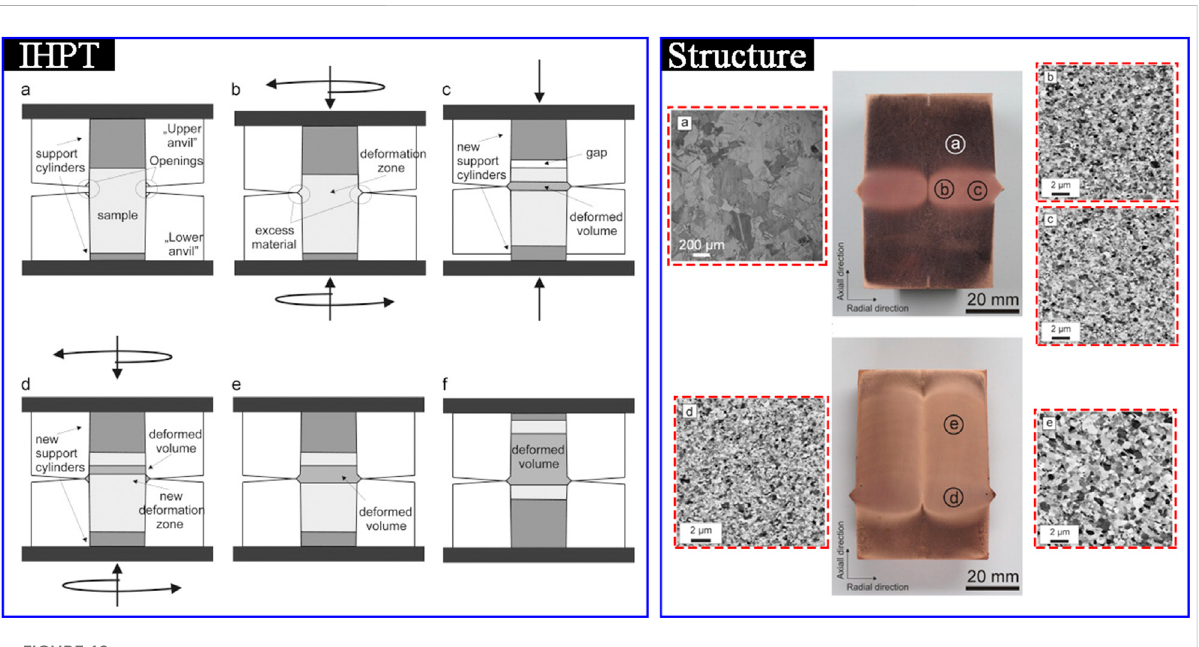
FIGURE 12 Schematic of IHPT process and its processed copper with microstructures in different positions (Hohenwarter,